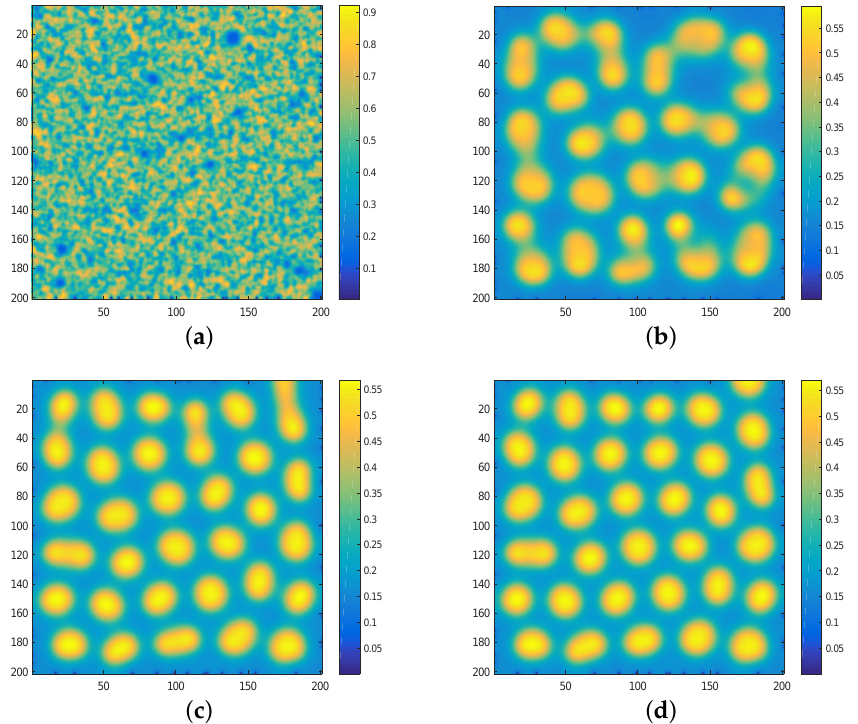
Figure 9. The patterns of u at ( a , c , d 12 , d 21 ) = ( 0.4,0.6,0.5,0.02 ) , the other parameters are fixed as in (36). Times: ( a ) t = 0, ( b ) t = 200, ( c ) t = 500, and ( d ) t =